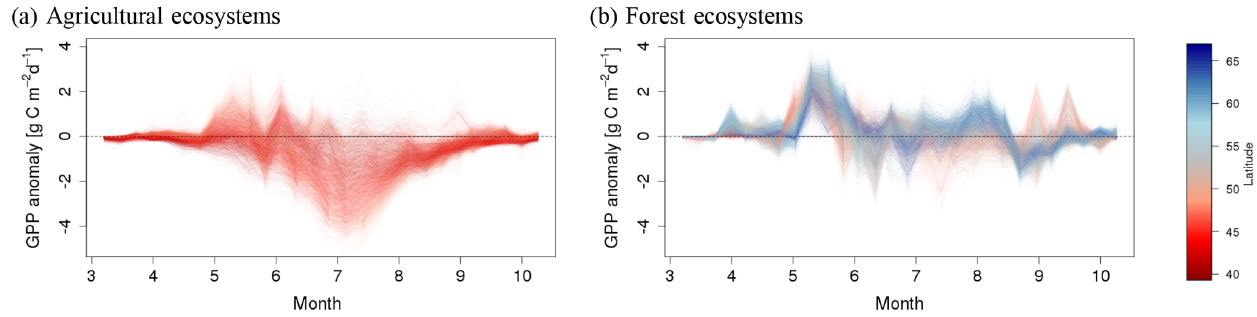
Figure 9. Temporal evolution of the GPP anomaly (reference period: 2001–2011) for (a) agricultural ecosystems and (b) forest ecosystems, colored according to the